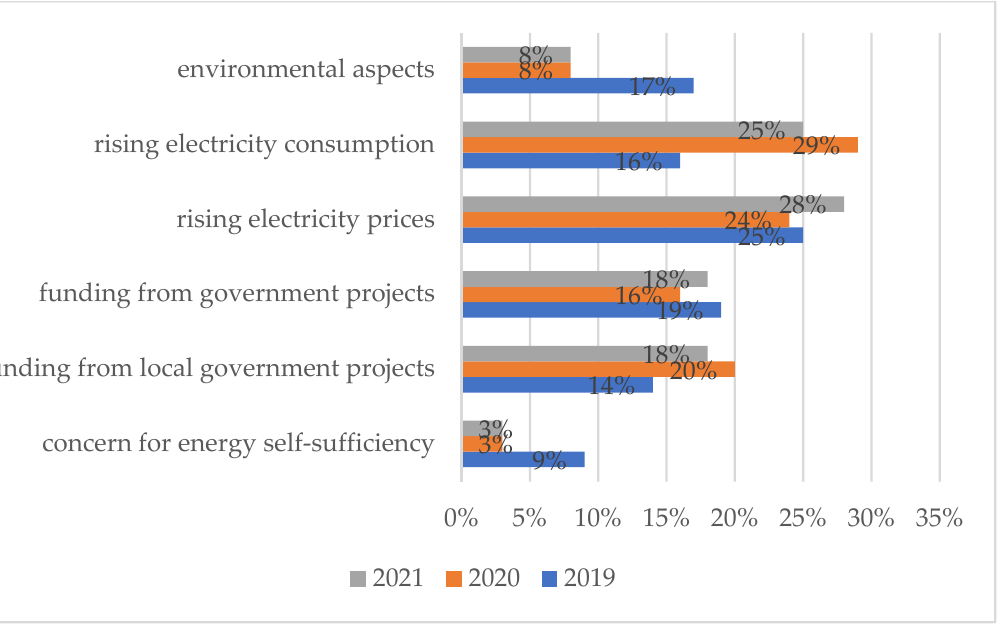
Figure 5. Determinants of photovoltaic panel installation in the area of Szemud Municipality be- tween 2019 and 2020.